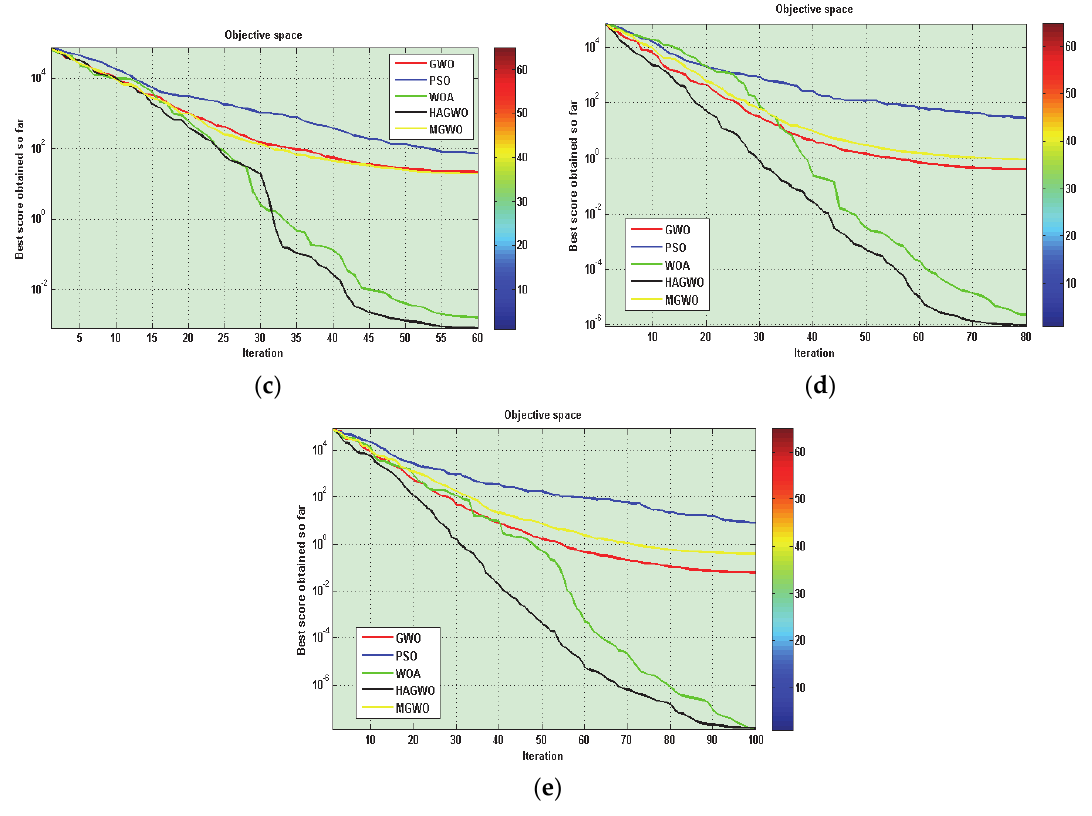
Figure 1. Convergence graph of metaheuristics. ( a ) Dim 20; ( b ) Dim 40; ( c ) Dim 60; ( d ) Dim 80; ( e ) Dim 100.